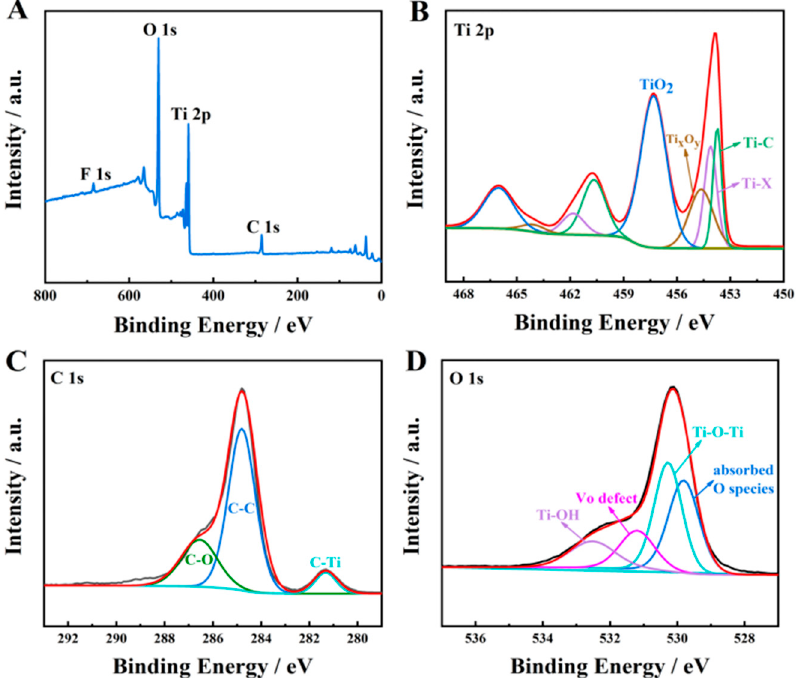
Figure 2. XPS survey spectrum of ( A ) TiO 2 -MXene, and high-resolution spectra of ( B ) Ti 2p, ( C ) C 1s and ( D ) O 1s. and ( D ) O